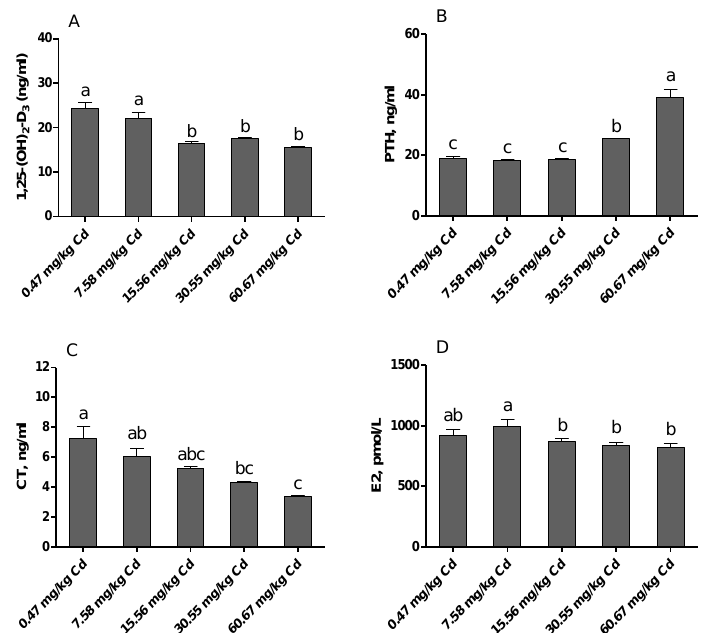
Figure 3. E ff ects of Cd on hormone levels in serum of laying hens. ( A ) 1,25-(OH) 2 -D 3 , 1,25- dihydroxyvitamin D3; ( B ) PTH, Parathyroid Hormone; ( C ) CT, calcitonin; ( D ) E2, Estradiol. Values are presented as the mean ± SE ( n = 8). a–c Means with different superscript letters are significantly different ( p <0.05).